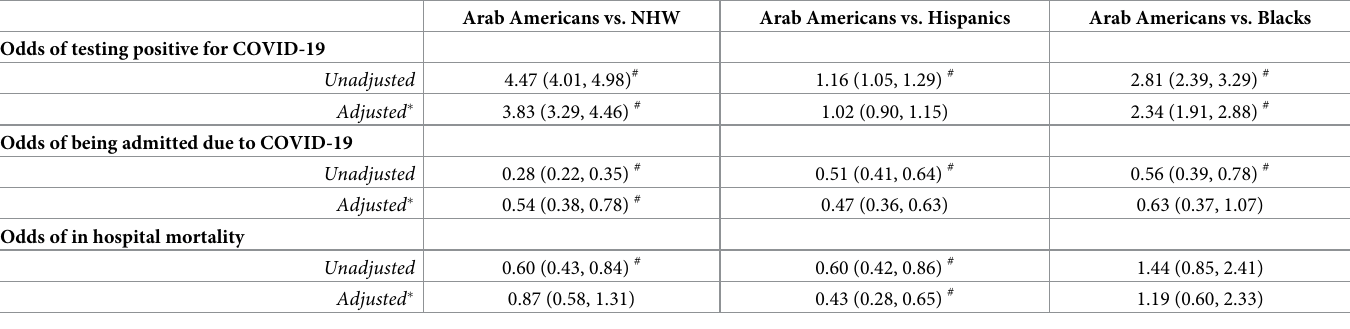
Table 3. Logistic regression models examining differences between Arab American patients and other racial and ethnic groups on odds of testing positive for COVID-19, being admitted due to COVID-19, and in-hospital mortality for patients at Sharp Grossmont hospital between March 1, 2020 and January 31, 2021. Arab Americans vs.